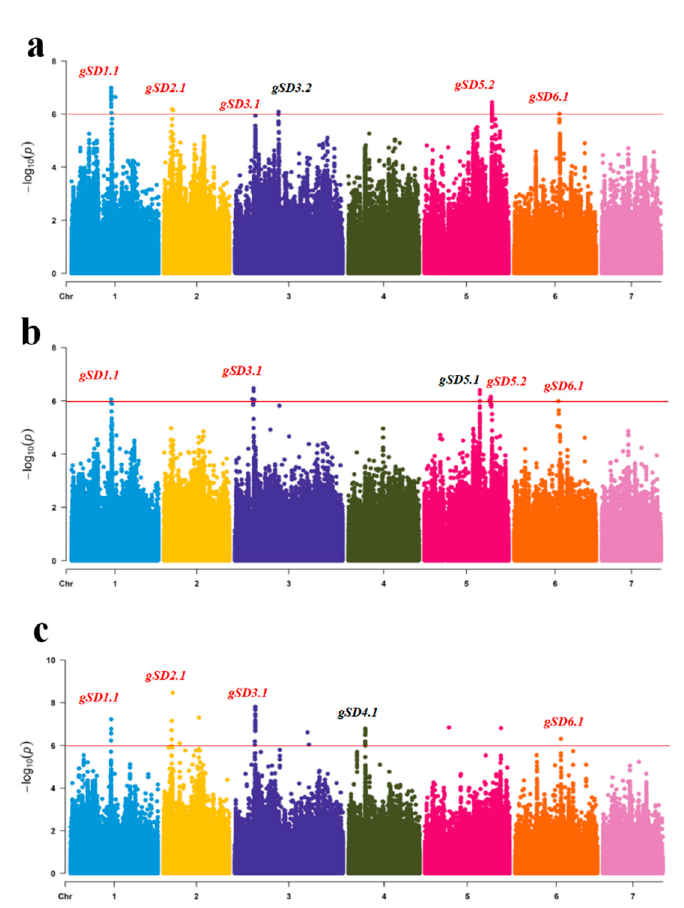
Figure 3. Genome-wide association study (GWAS) analysis of cucumber stem diameter in ( a ) 2020S; ( b ) 2020A; ( c ) 2021A. Manhattan plots of the cucumber stem diameter in three seasons. The red line represents a significant threshold of GWAS ( − log 10 p )= 6). The red font indicates repeatedly detected loci.